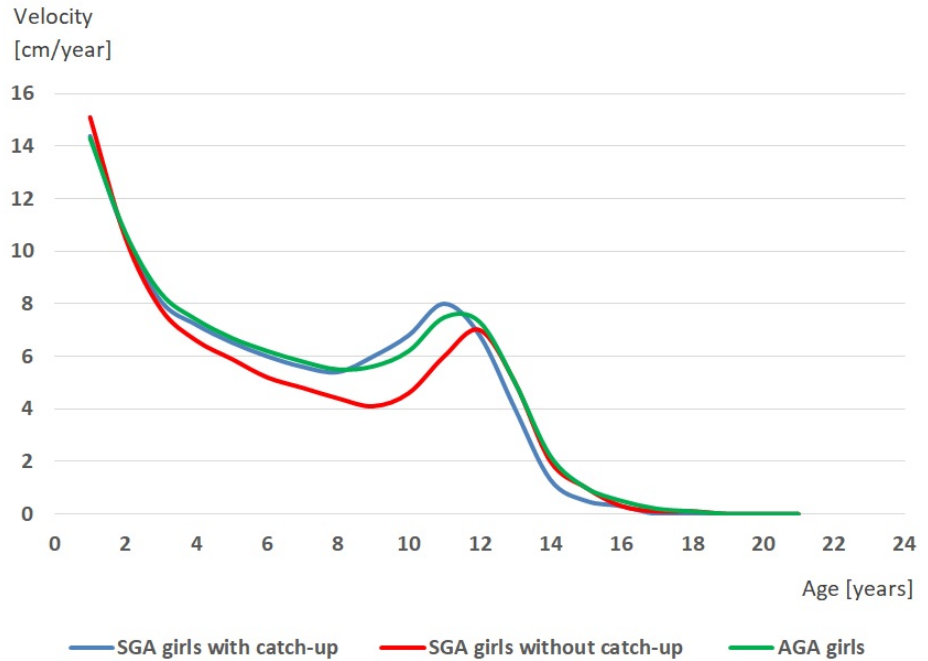
Figure 4. Growth velocity curves of body height of girls born small for gestational age (SGA) with catch-up growth, girls born small for gestational age (SGA) without catch-up growth, and girls born appropriate for gestational age (AGA).